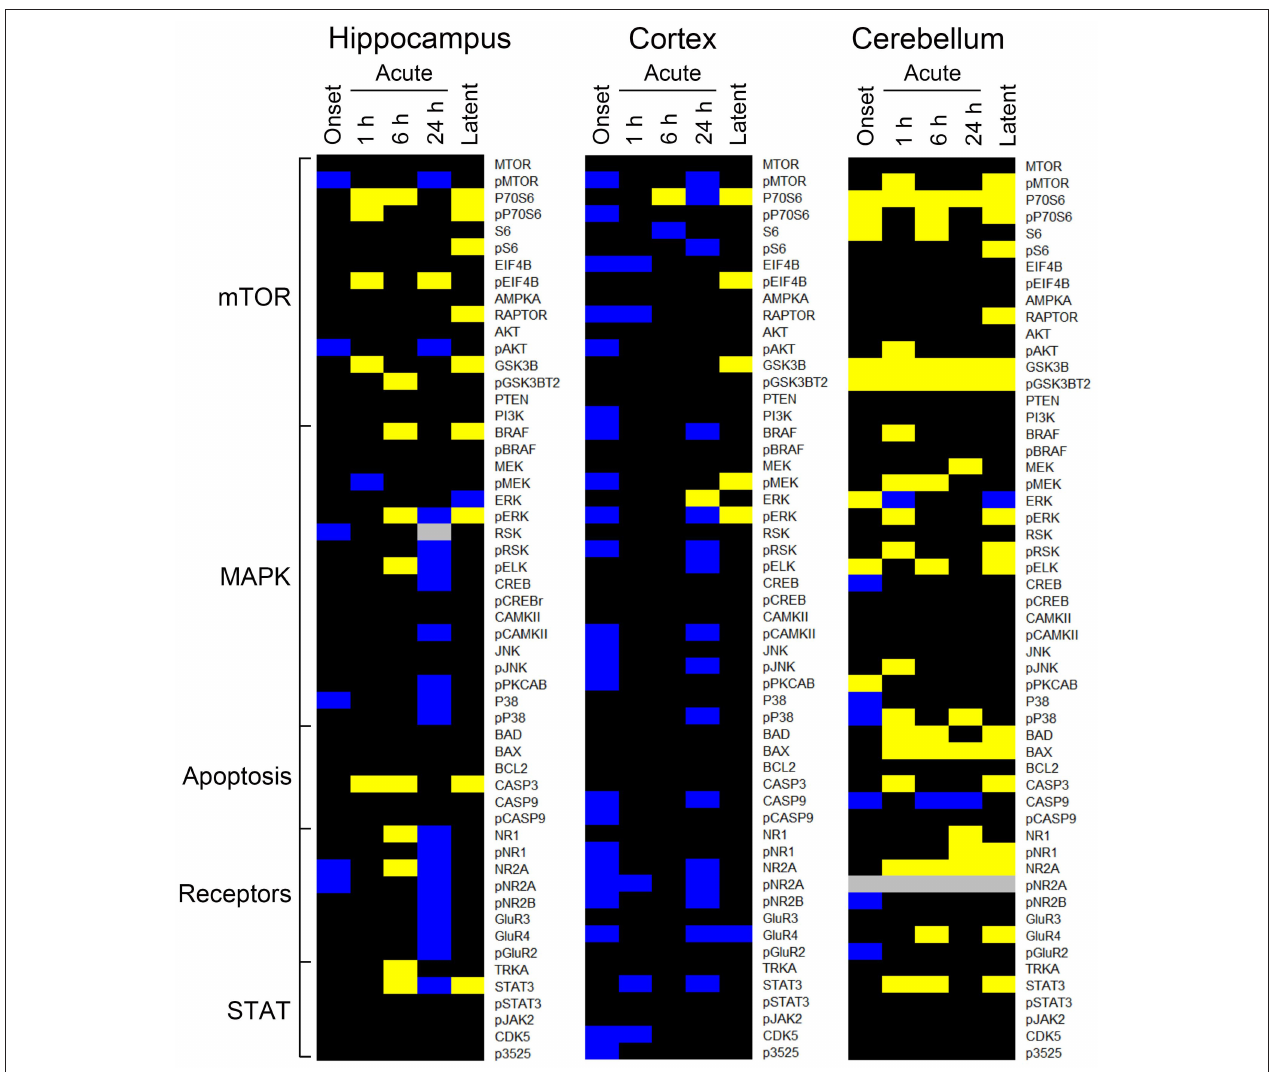
FIGURE 3 | Changes in protein expression in saline-treated mice. Heatmaps show proteins with an average expression level in saline treated mice at the first five time points significantly different from saline treated mice at the chronic time point. Only proteins with differences ≥ 15% as determined by a three level mixed effects model, with p ≤ 0.0005, and a Benjamini-Hochberg correction for multiple testing applied with a false discovery rate of 0.05 are shown. Data derived from Supplementary Table 3 . Proteins are grouped by general category. Yellow, increased; blue, decreased; black, no difference; gray, not measured. n = 5 for each